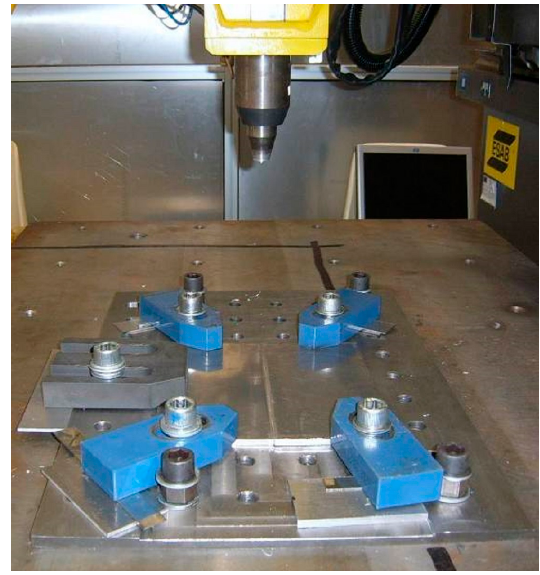
Figure 4. Positioning of the workpiece on the fixture table.